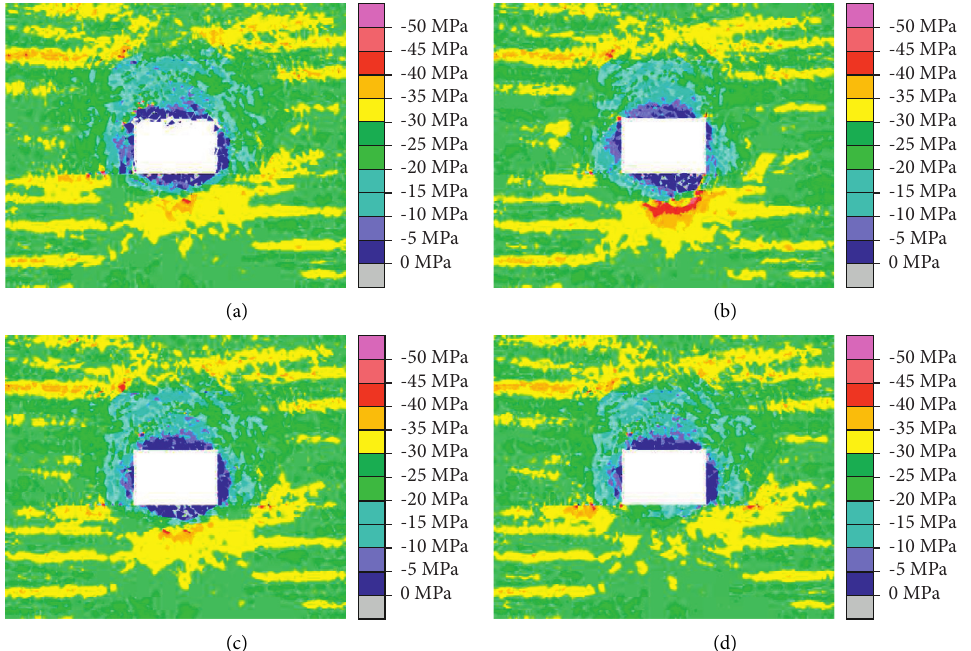
Figure 14: Maximum principal stress of RSR with different support schemes. (a) Scheme 1. (b) Scheme 2. (c) Scheme 3. (d) Scheme 4.